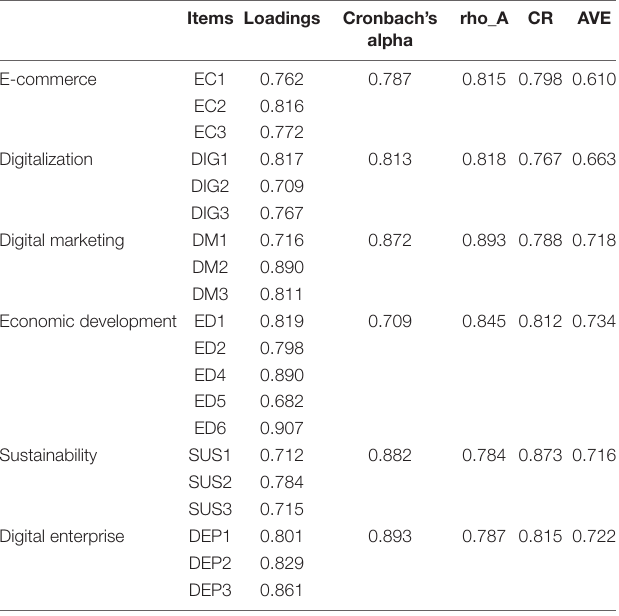
TABLE 1 | Measurement model.